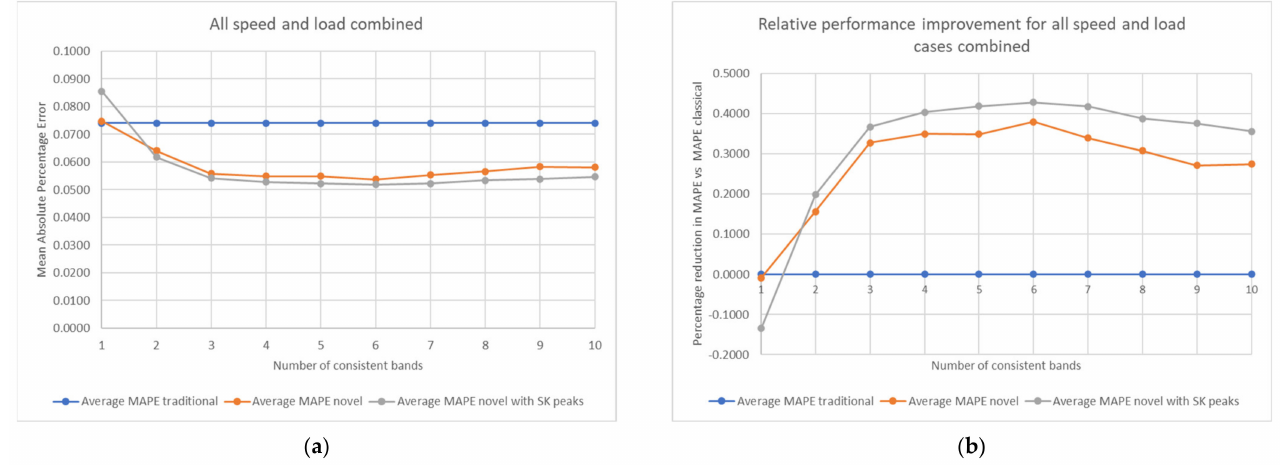
Figure 15. Performance of the various techniques; ( a ) absolute values when combining speed and load; ( b ) relative performance improvement with speed and load